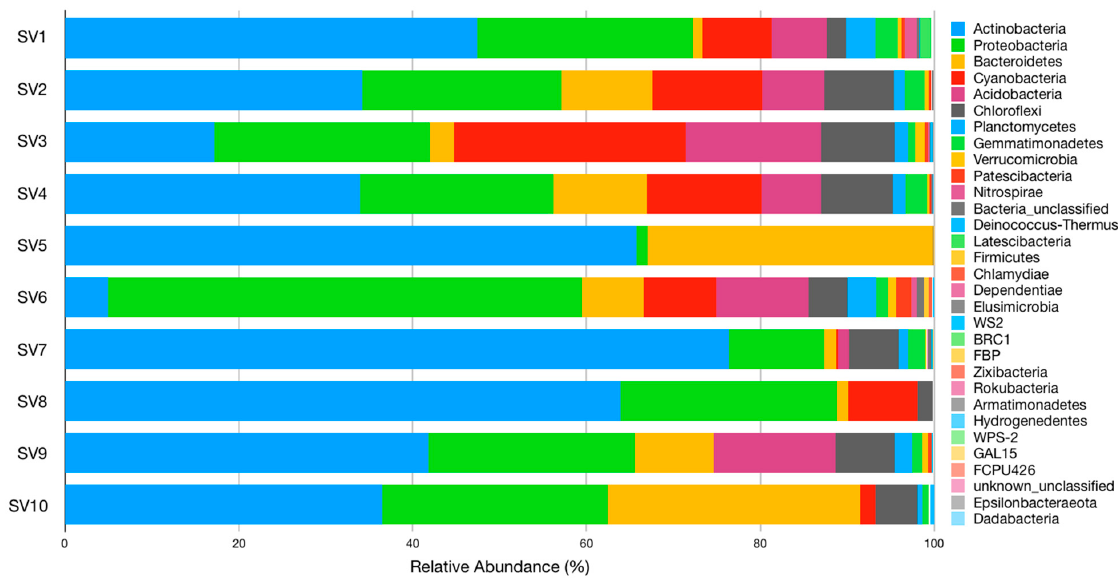
Figure 1. Relative abundance and distribution of bacterial phyla in each sample.